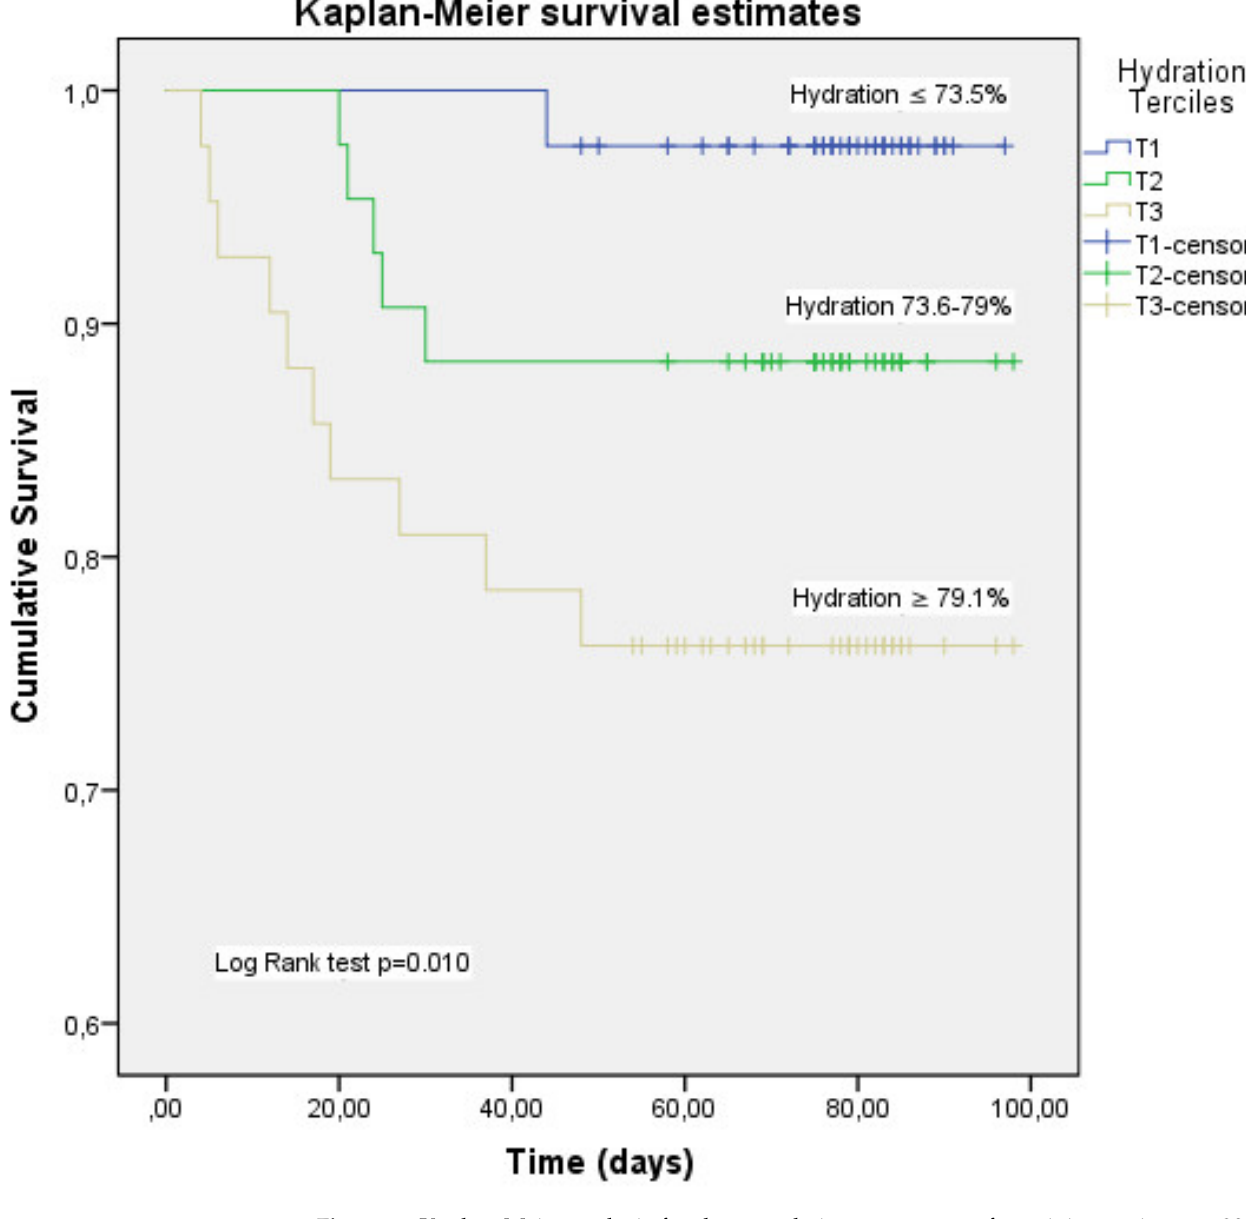
Figure 2. Kaplan–Meier analysis for the cumulative percentage of surviving patients at 90 days according to hydration percentage tertiles. The 33rd and 66th percentiles of hydration percentage were used as the cut-off point to divide the patients with acute COVID-19 disease into 3 groups (T1, T2, T3) and made the Kaplan–Meier plot. Kaplan–Meier product-limit estimator shower that higher hydration (T3) was significantly linked with higher mortality rates (log-rank test, p = 0.010). Mortality was mainly concentrated in